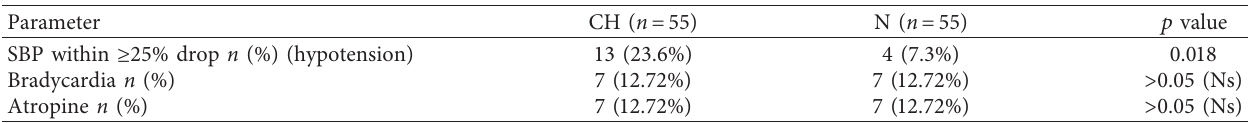
Chi-square test with p < 0 . 05 considered statistically significant, Ns: nonsignificant, SBP: systolic blood